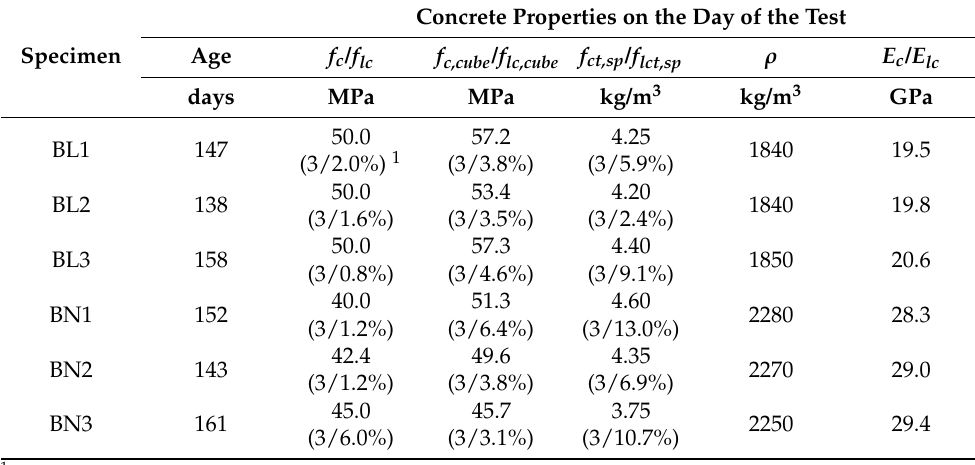
Table 4. Concrete properties on the day of the test.